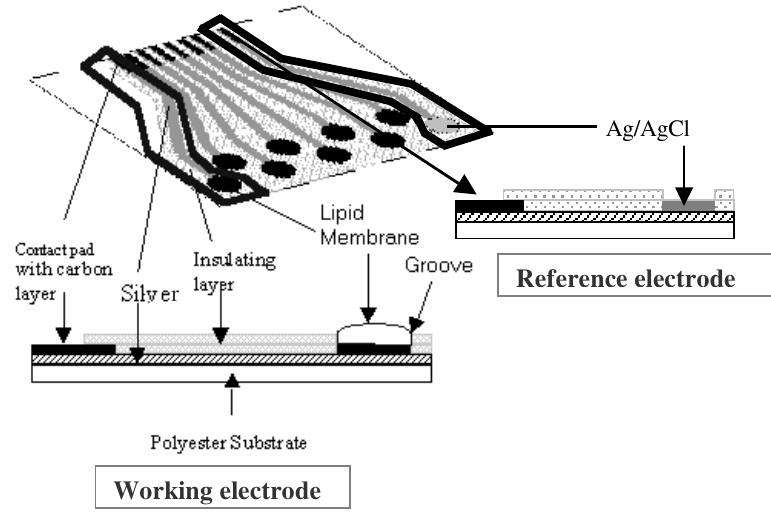
Figure 1. Cross-Sectional view of a screen-printed lipid